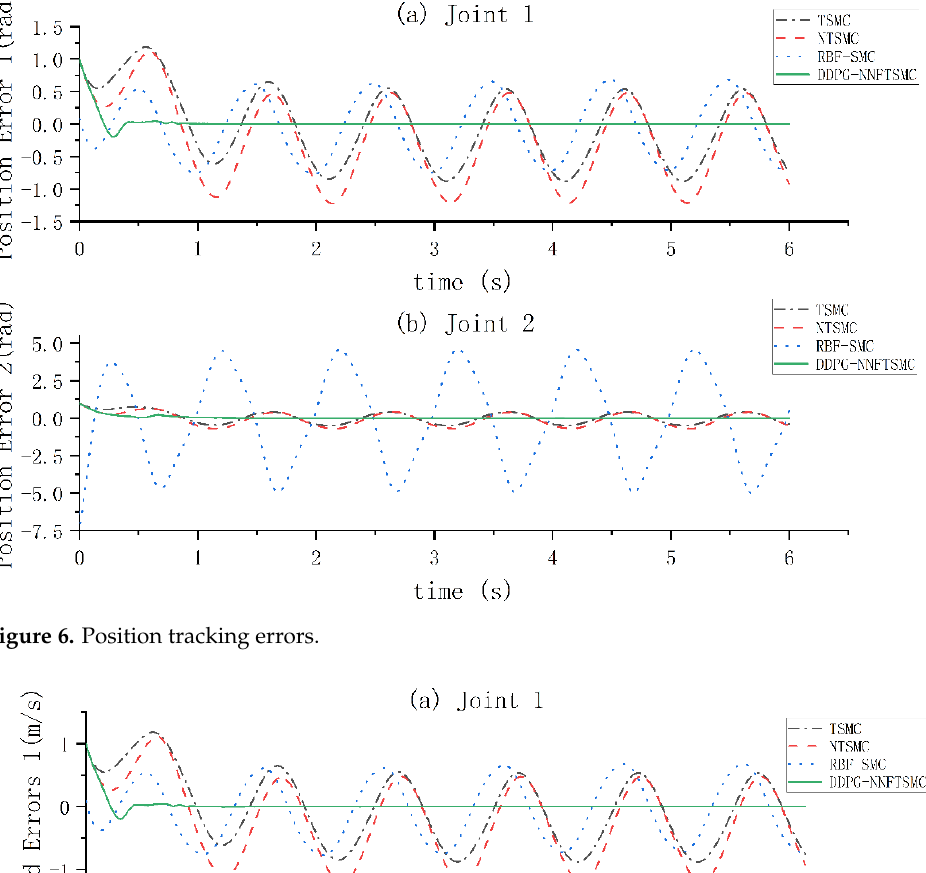
Figure 6. Position tracking errors.